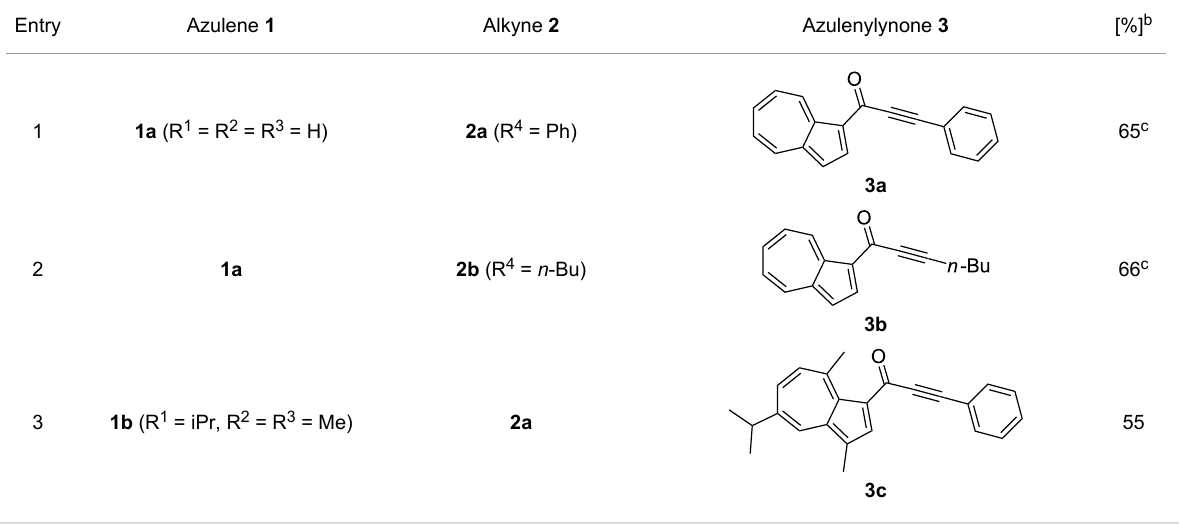
Table 2: Three-component synthesis of azulenyl- and guaiazulenylynones 3 .